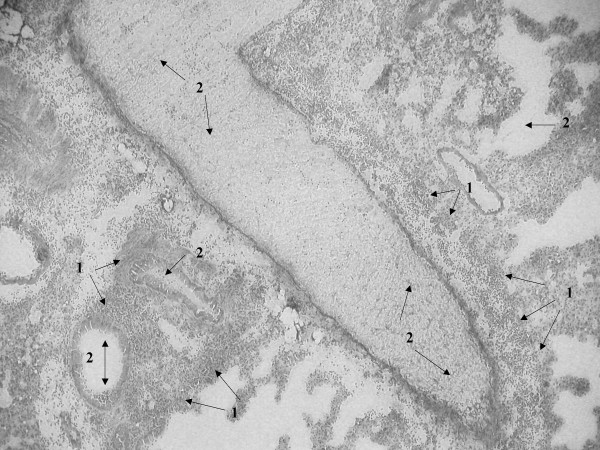
Light microscopy of lung tissue from mice infected with 106CFU of S. pneumoniae. SP-D-/- 24 h post-infection (figure 5), SP-D+/+ 24 h post-infection (figure 6), SP-D-/- 48 h post-infection (figure 7) and SP-D+/+ 48 h post-infection (figure 8). Magnification ×250 for figures 5 and 8, ×400 for figures 6 and 7. See results for description of arrows.